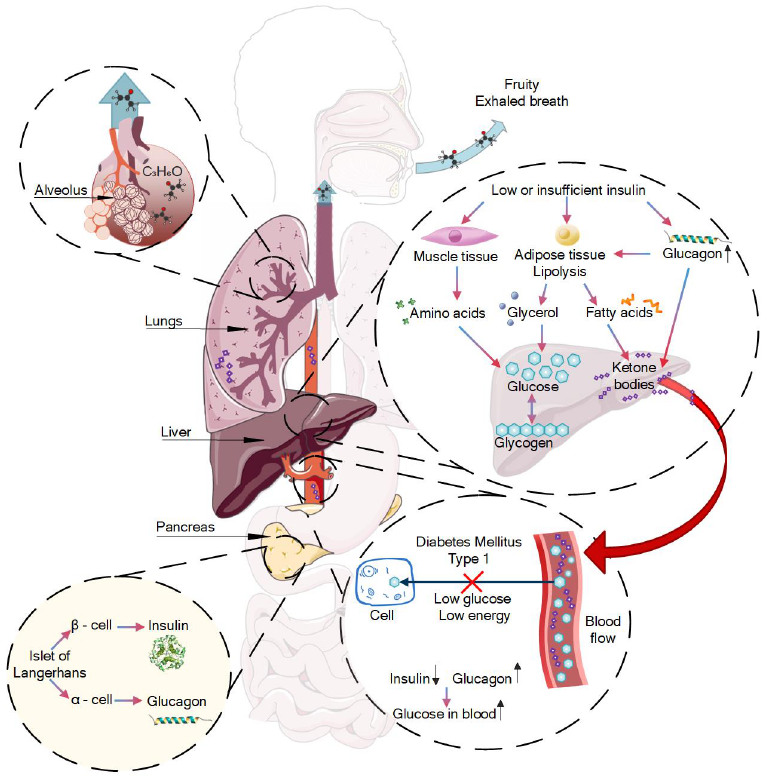
Figure 1. The mechanism of VOC formation in T1DM human